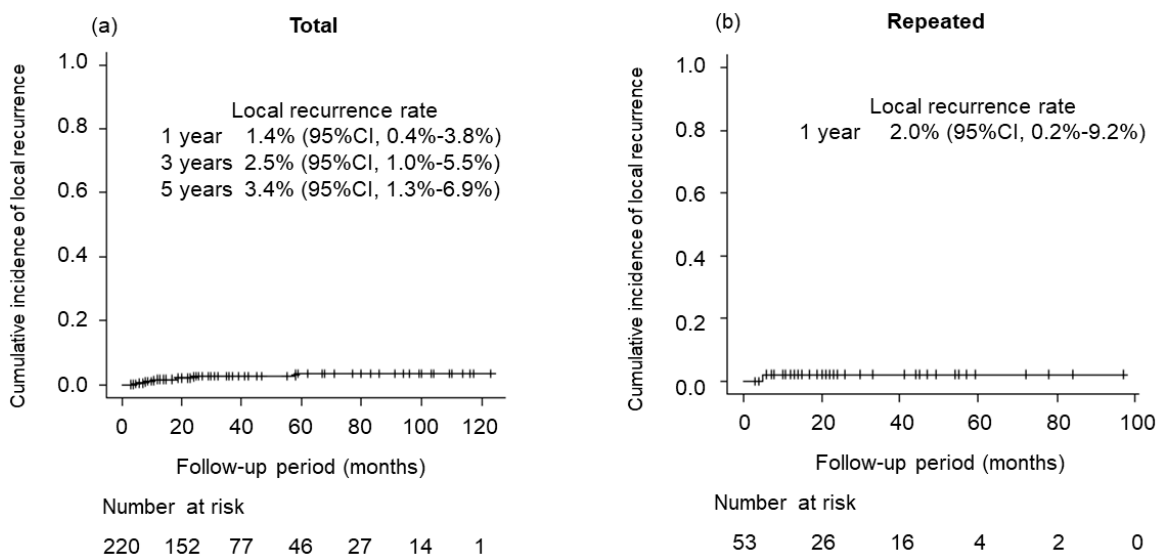
Figure 4. Local recurrence (LR) rate for total cases treated with SBRT and repeated cases treated with SBRT. ( a ) Three- and 5-year LR rates for total cases were 2.5% (95% CI, 0.4–3.8%) and 3.4% (95% CI, 1.3–6.9%), respectively. ( b ) Only one case showed LR within 1 year after second SBRT.